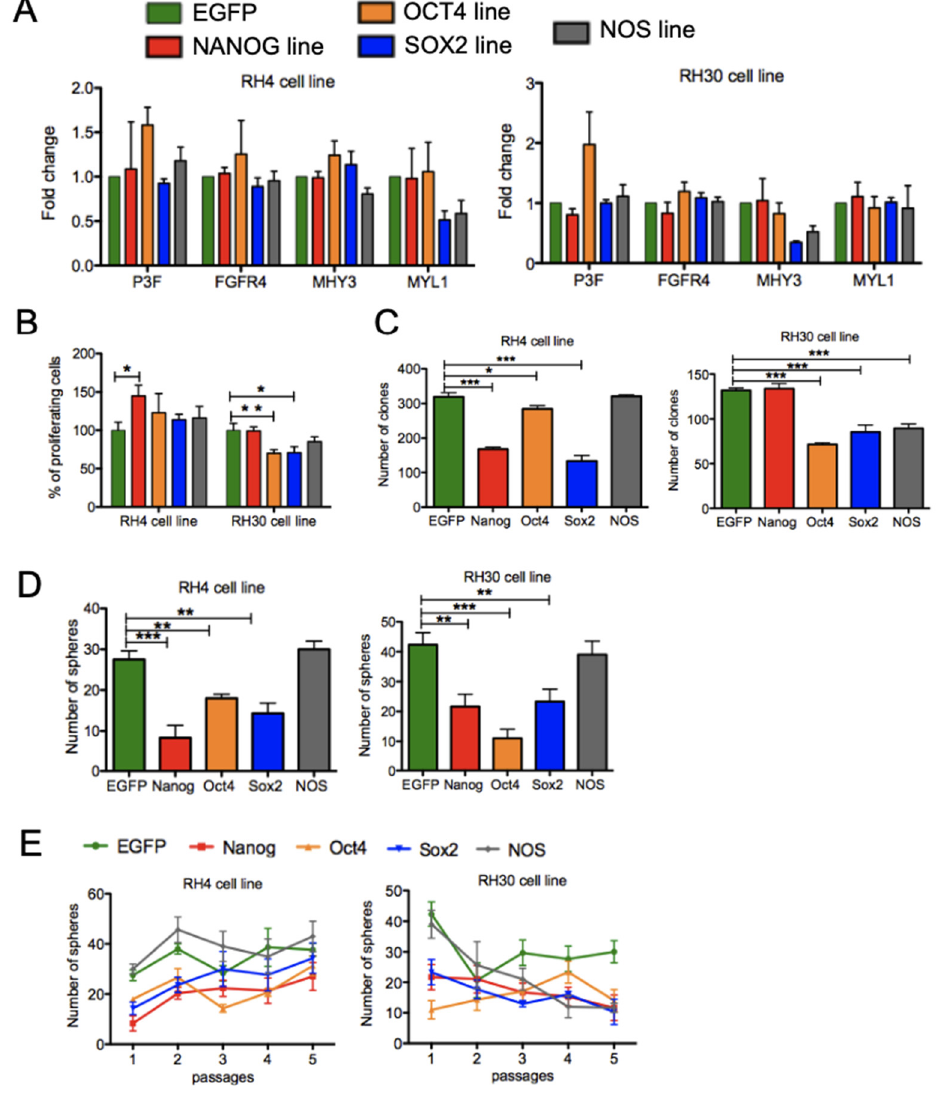
Figure 4. Overexpression of the core stem cell factors does not enhance stem cell properties. ( A ) RNA expression analysis and RH30 transgenic cell lines overexpressing the core stem cell genes NANOG, OCT4, and SOX2 singularly or simultaneously (NOS line). For each FPRMS line an EGFP transgenic cell line was generated and used as control line. Fold changes are calculated compared to the EGFP lines. ( B ) Cell proliferation assay (BrdU incorporation) in RH4 and RH30 transgenic cell lines. Percentages are calculated relative to EGFP control line. Represented are means of triplicates ( n = 3). Statistical analysis: Unpaired t -test, ** p < 0.005, * p < 0.05. ( C ) Clonogenic assay with RH4 and RH30 transgenic cell lines. Clones were stained with crystal violet and quantified. Represented are means of triplicates ( n = 3). Statistical analysis: Unpaired t -test, *** p < 0.0005, * p < 0.05. ( D ) Primary sphere formation with RH4 and RH30 transgenic cell lines. Represented are means of triplicates ( n = 3). Statistical analysis: Unpaired t -test, *** p < 0.0005, ** p < 0.005. ( E ) Sphere assay with RH4 and RH30 lines overexpressing the stem cell genes.